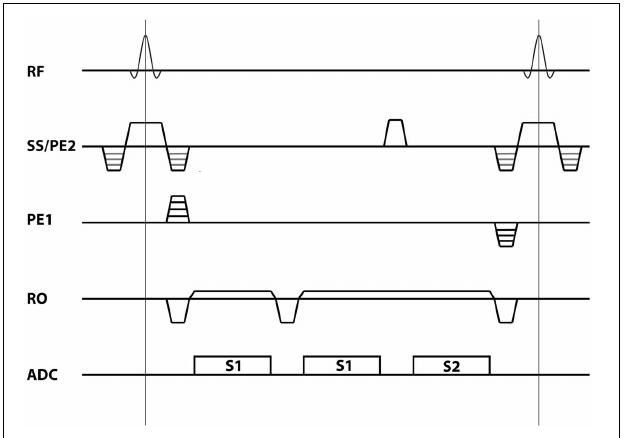
FIGURE 1 | Sequence diagram. The multi-echo non-balanced SSFP for the case of two S1 echoes followed by a single S2 echo as used in the current